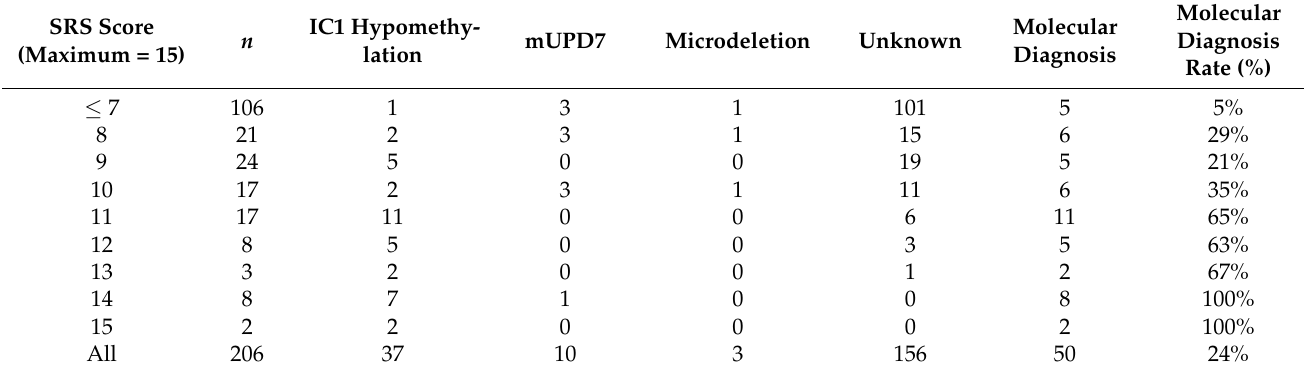
Table 2. Epigenetic and genetic defects and molecular diagnosis rates of the 206 subjects by SRS score.